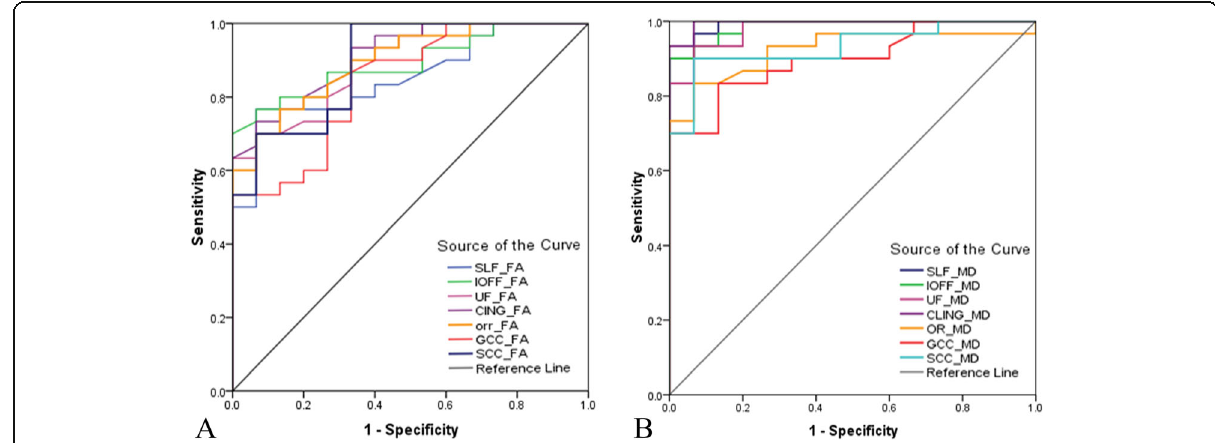
Fig. 4 ROC curve analysis for FA ( a ) and MD ( b